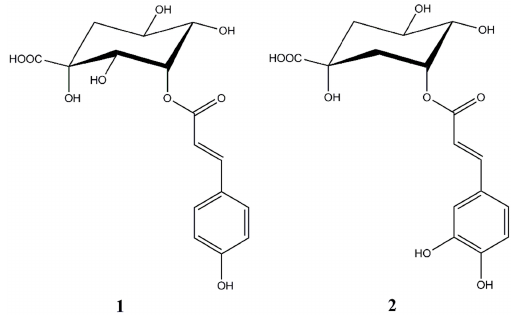
Figure 1. Chemical structures of 3- p - trans -coumaroyl-2-hydroxyquinic acid (CHQA, 1 ) and chlorogenic acid ( 2 ).